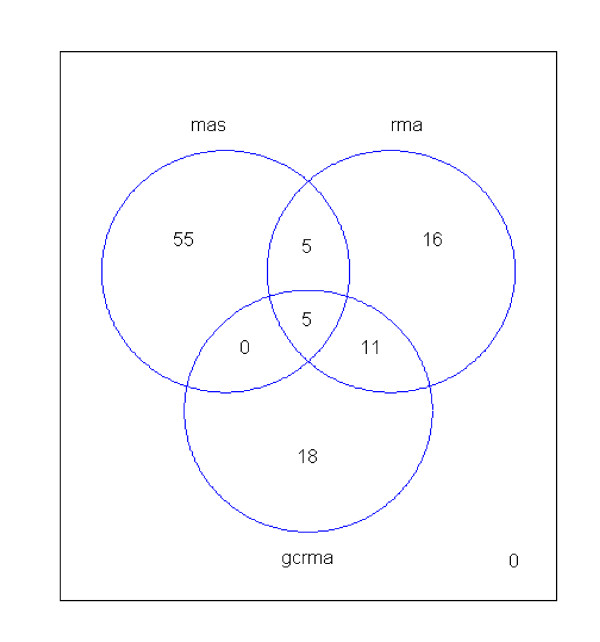
Distribution of 136 differentially expressed genes across three different data-processing methods (MAS5.0; 65, RMA; 37 and GCRMA; 34). The 21 differentially expressed genes were defined as those detected in at least two data processing methods.